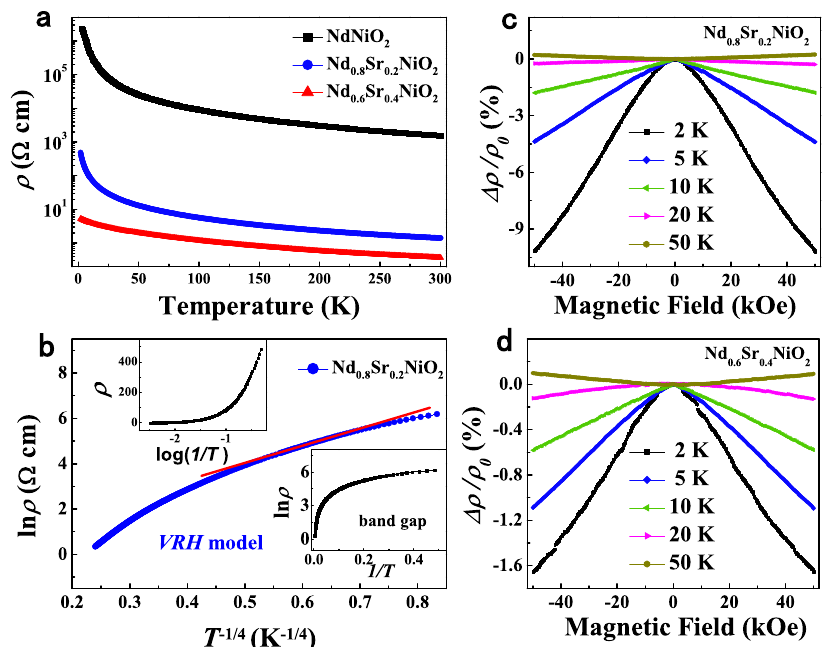
Fig. 4 Temperature dependent resistivity and magnetoresistance at ambient pressure. a Temperature dependence of resistivity for Nd 1 − x Sr x NiO 2 ( x = 0, 0.2, 0.4) samples. b Temperature dependence of resistivity in ln ρ versus T − 1/4 for Nd 0.8 Sr 0.2 NiO 2 . The top inset shows the curve of ρ versus log(1/ T ) and the bottom inset shows the curve of ln ρ versus 1/ T (band gap model) for Nd 0.8 Sr 0.2 NiO 2 . c, d Field dependence of magnetoresistance Δ ρ / ρ 0 at different temperatures for Nd 0.8 Sr 0.2 NiO 2 and Nd 0.6 Sr 0.4 NiO 2 samples. Both samples exhibit a reversal from negative magnetoresistance to positive magnetoresistance above 20 (cid:2) M Þ = Δ H is thus taken as the pure signal values χ P ¼ ð M 3T 1T